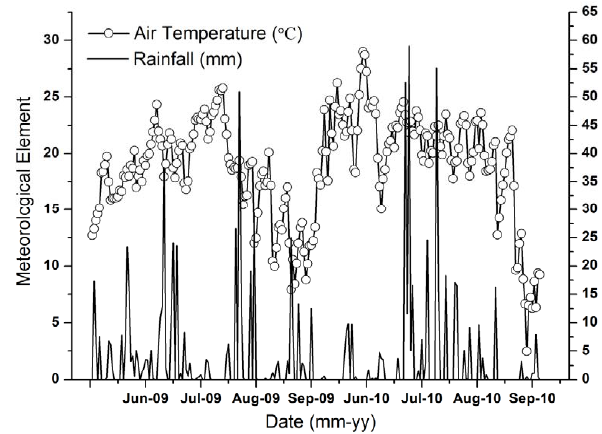
Fig. 2. Air temperature and rainfall in the Sanjiang Plain Wetland Station during the growing seasons of 2009 and